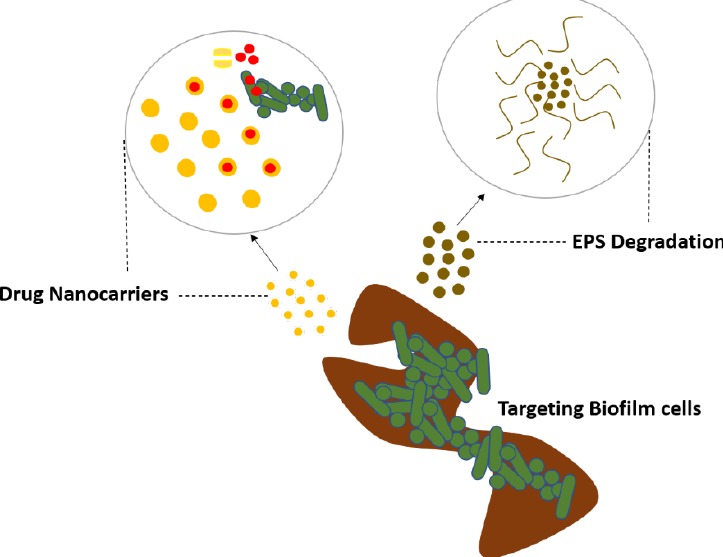
Figure 10. Nanoparticles targeting the biofilm to treat the biofilm-associated infections.